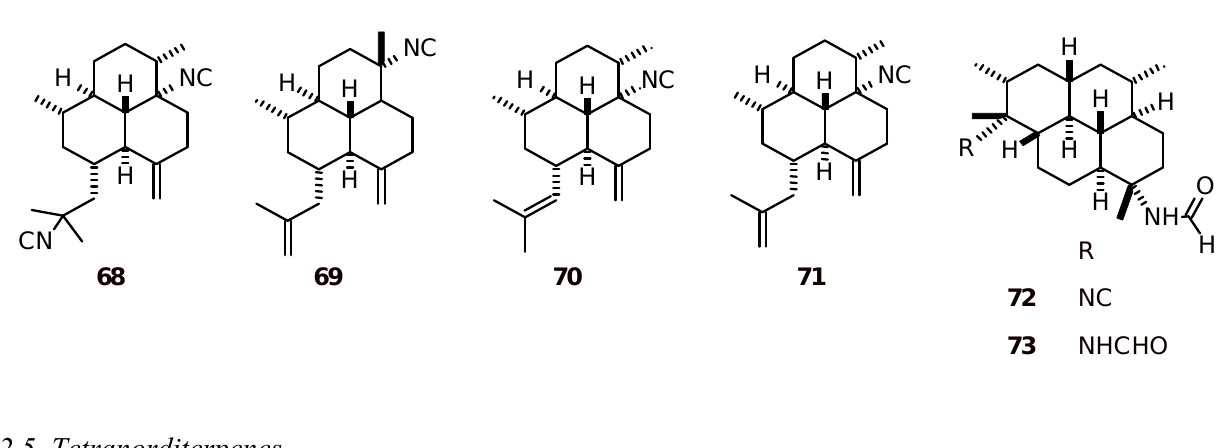
Figure 7. Structures of nitrogenated diterpenes 68 - 73